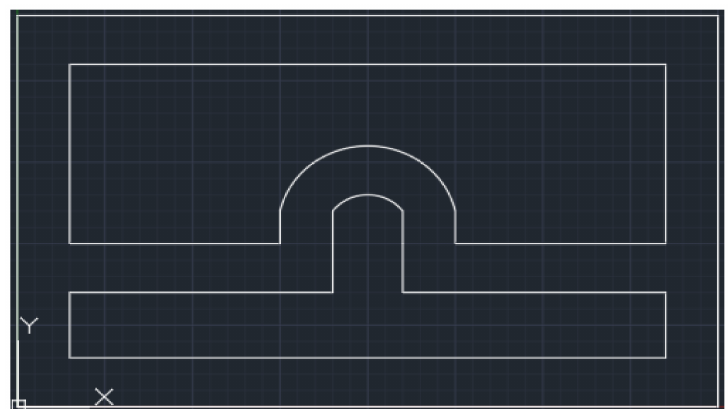
Figure 2. Drawing Mimicking ICON wall configuration [20].